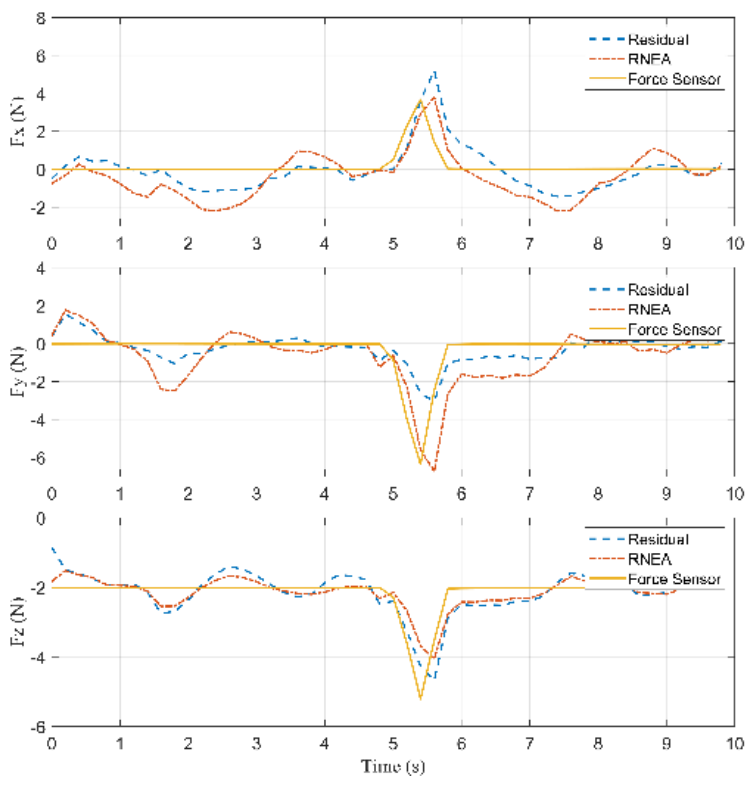
Figure 18. Residuals, the computed forces by RNEA and the force sensor in Case